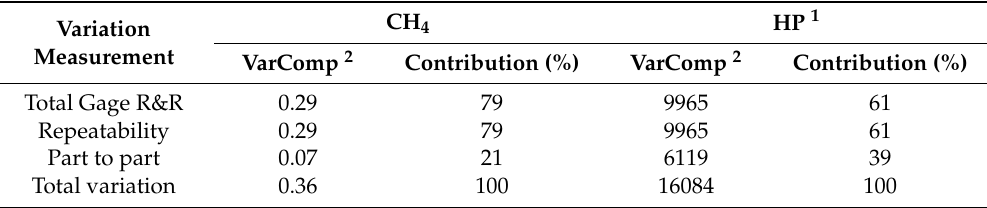
Table 3. Repeatability study of the open-circuit indirect calorimetry